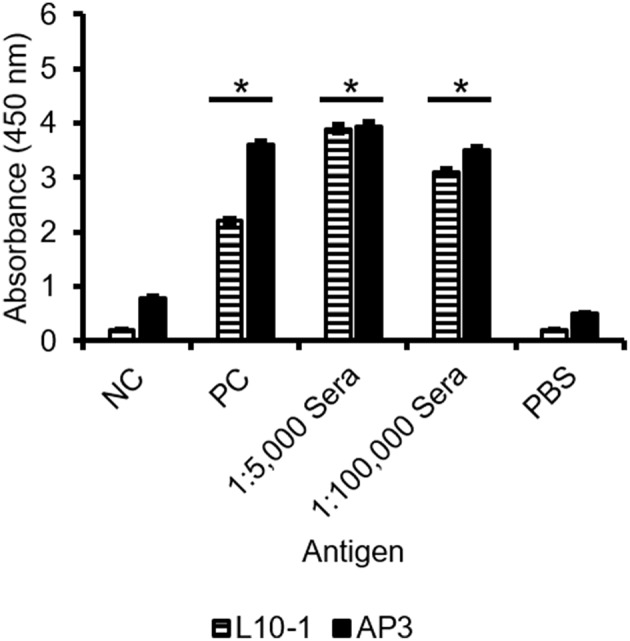
Detection of GM in sera by sandwich ELISA using GM-specific antibodies. Microtiter plates were coated with 400 ng/ml purified mAb AP3 and L10-1. After blocking free binding sites with 3% (w/v) skimmed milk, sera diluted 1:5,000 or 1:100,000 were applied and detected using the EB-A2 conjugate. The signal was measured in triplicate at 450 nm after 20 min substrate incubation (ABTS). PC: Aspergillus-positive control serum from the Platelia Aspergillus EIA. NC: negative control serum from the Platelia Aspergillus EIA. PBS: negative control. An asterisk denotes a statistically significant difference in antigen binding relative to the NC control serum (p < 0.005).